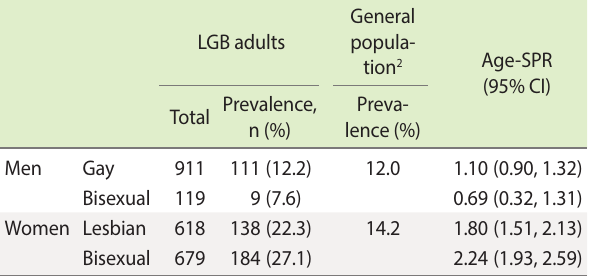
Table 2. SPR of poor self-rated health 1 be tween LGB population (2016) and the general population (2013-2015) 2 in Korea (N=2,327)